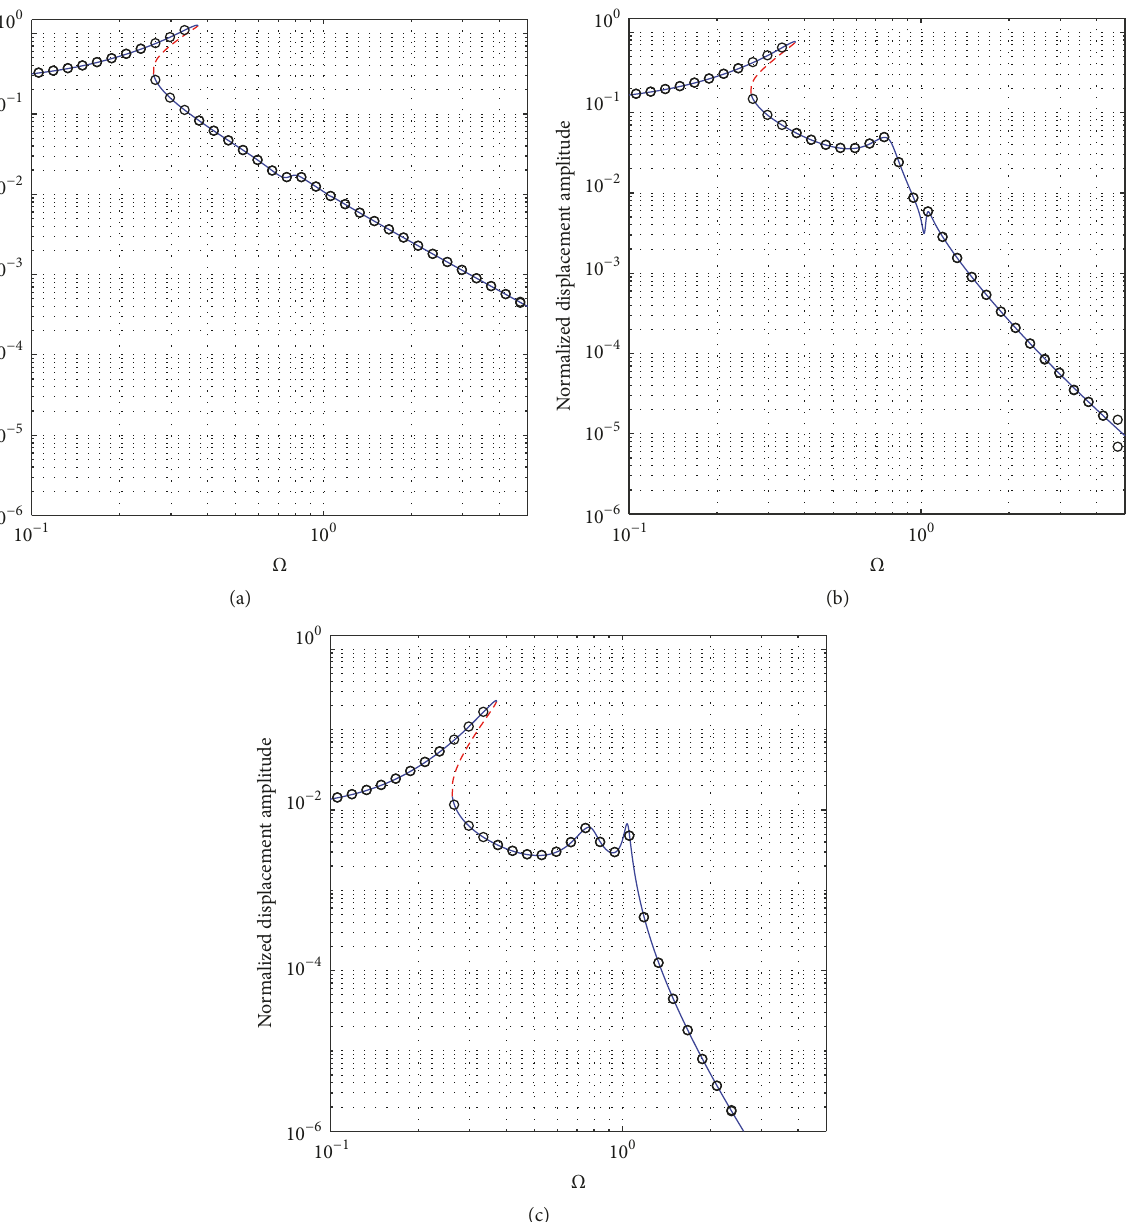
= 𝜁 = 𝜁 = 0.01 . (a) FRC of 𝑚 v 1 v 2 s